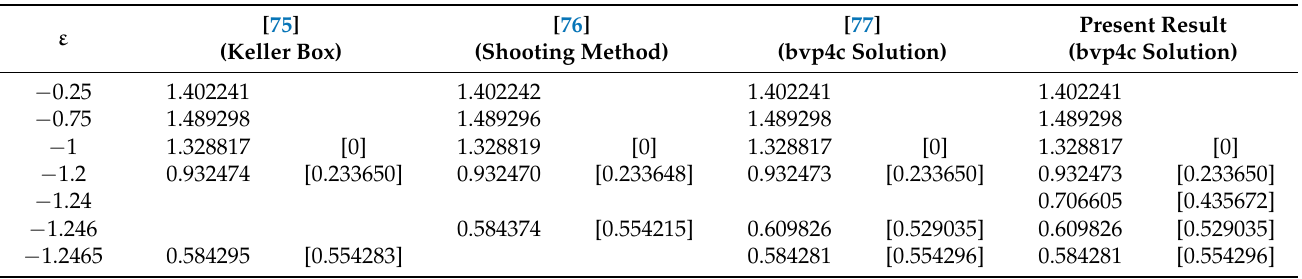
Figure 26. 𝜃(𝜂) on different nanoparticles 𝜑 1 . Figure 26. θ ( η ) on different nanoparticles ϕ 1 . Table 3. Numerical computation for f (cid:48)(cid:48) ( 0 ) when ϕ 1 = ϕ 2 = M = Υ = λ = 0 with several values of ε Table 3. Numerical computation for 𝑓”(0) when 𝜑 1 = 𝜑 2 = 𝑀 = ϒ = 𝜆 = 0 with several values of 𝜀 and 𝑃𝑟 = 6.2 [75 – 77]. and Pr = 6.2